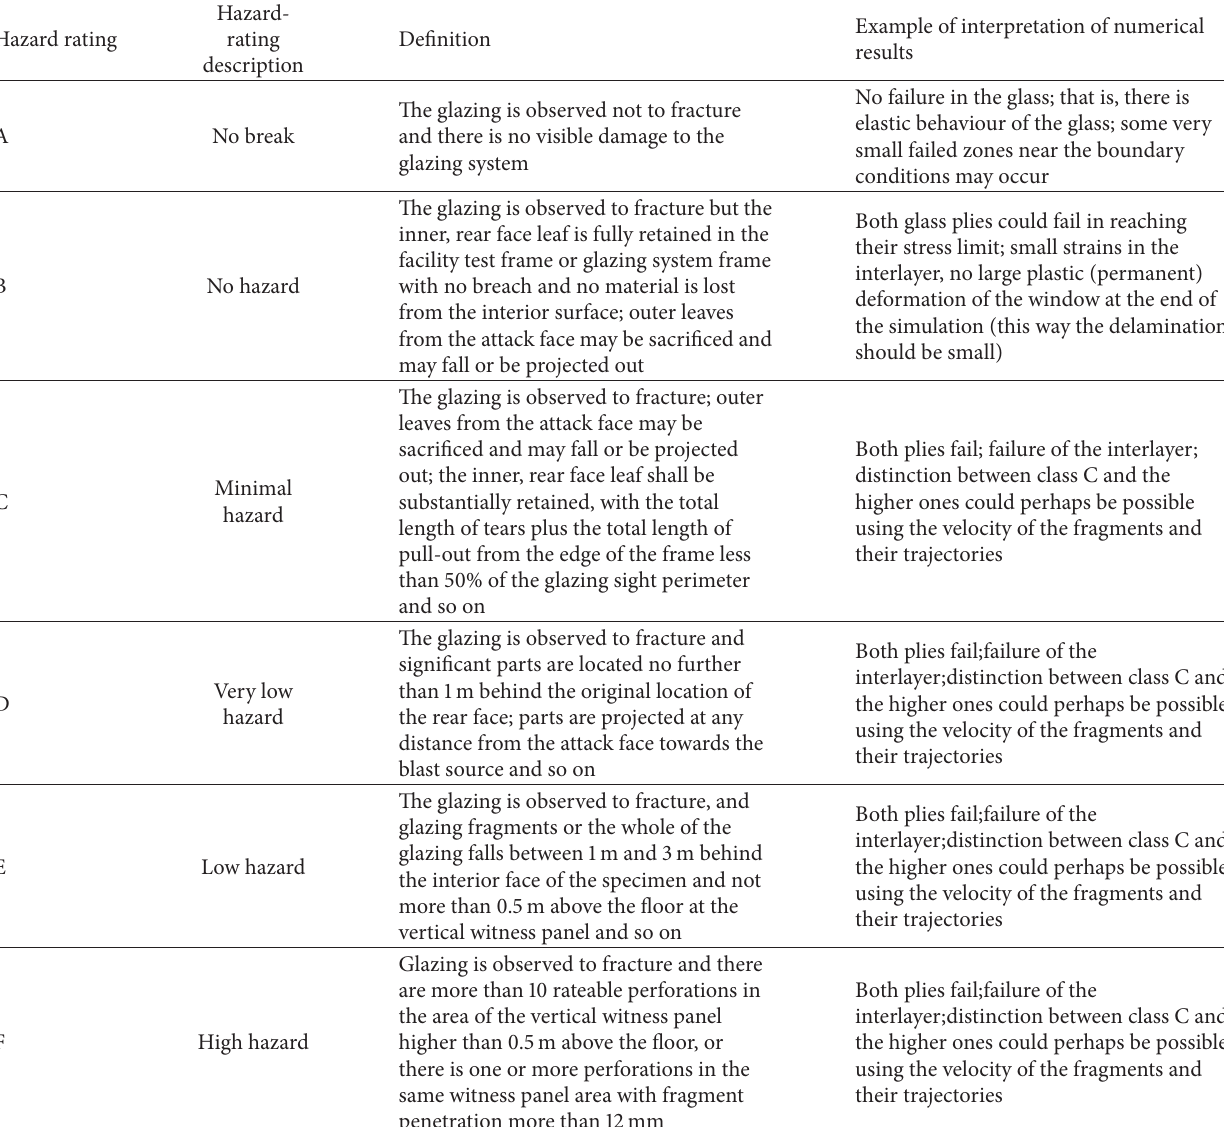
Table 6: Hazard-rating criteria for arena tests according to ISO 16933:2007